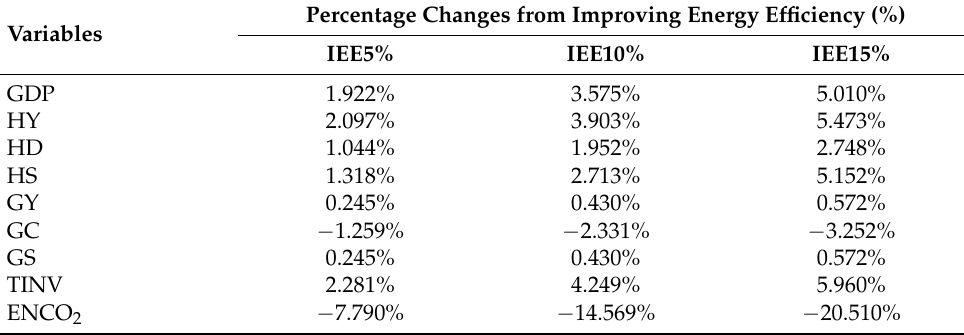
Table 4. Impacts of different scenarios on macroeconomy and social